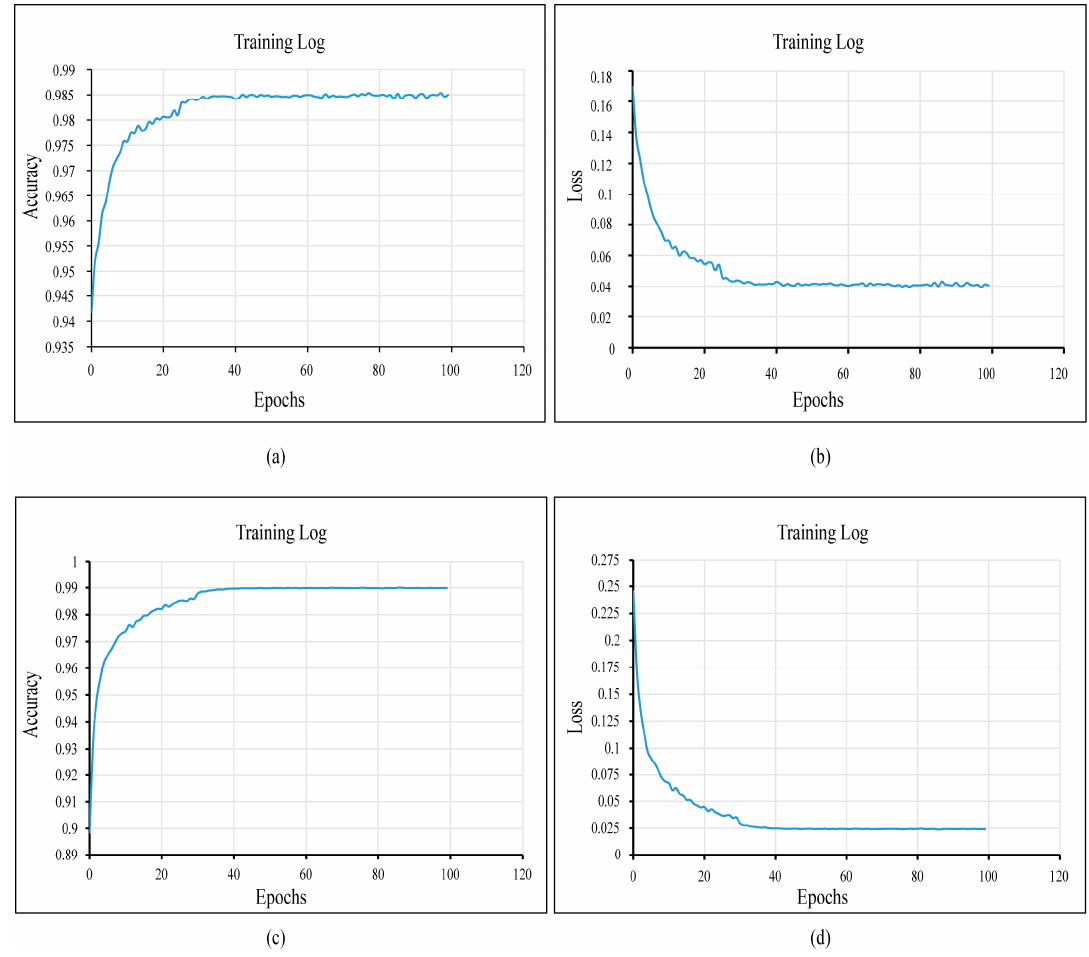
Figure 4. Plots showing the accuracy and loss of the Res-U-Net network for training the datasets. The training accuracy ( a ) and the loss ( b ) change with the epochs increasing in Potsdam. The training accuracy ( c ) and the loss ( d ) change with the epochs in Vaihingen.